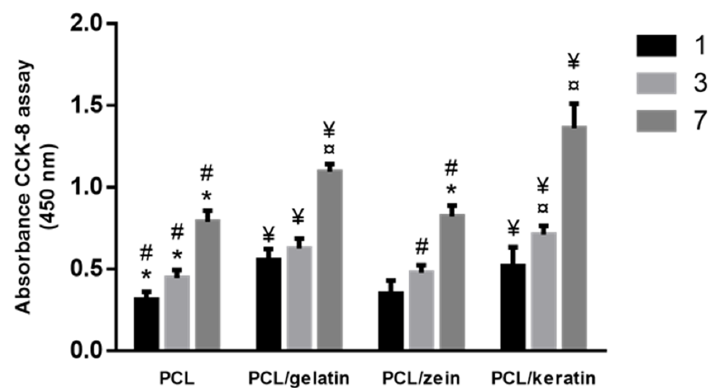
Figure 5. Study of hMSC viability onto protein-rich fibers until 7 days: ¥ denotes statistical significance PCL fibers; * denotes statistical significance difference compared to PCL/gelatin fibers; ¤ denotes statistical significance compared to PCL/zein fibers; # denotes statistical significance difference compared to PCL/keratin fibers (p < 0.05).